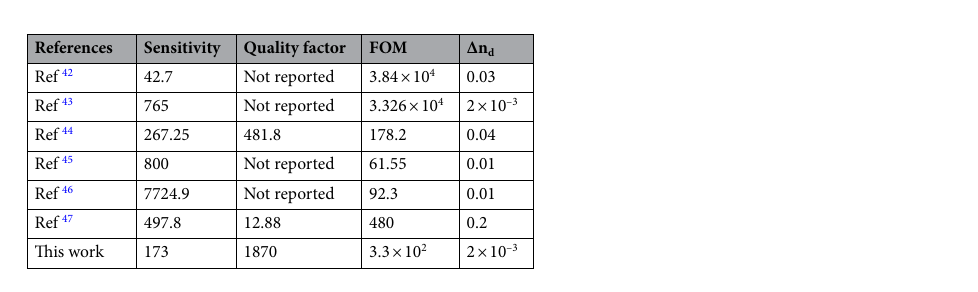
Table 1. Comparison of the proposed sensor with some of the reported